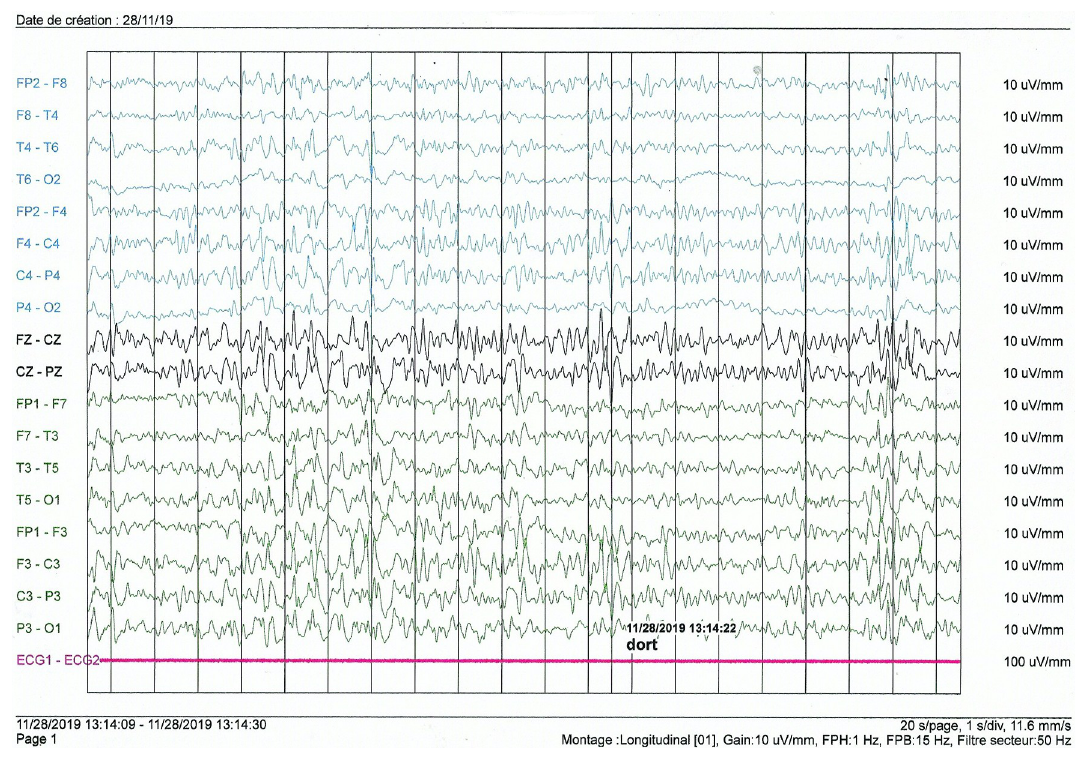
Fig 2. Interictal electroencephalogram of an 11-year-old girl (case 1).